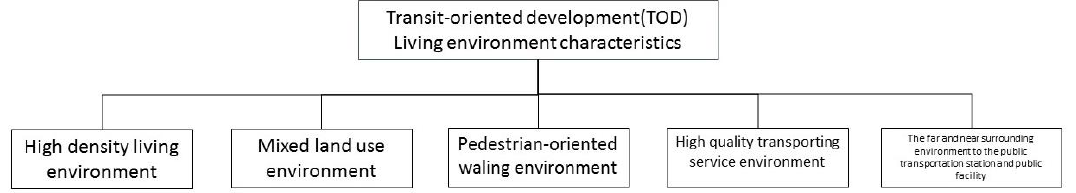
Figure 1. TOD (transit-oriented development) living environment characteristics.